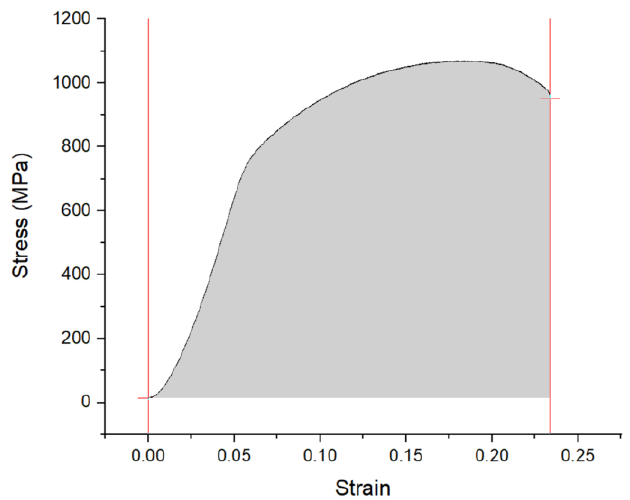
Figure 1. Typical Stress-Strain curve for OPH